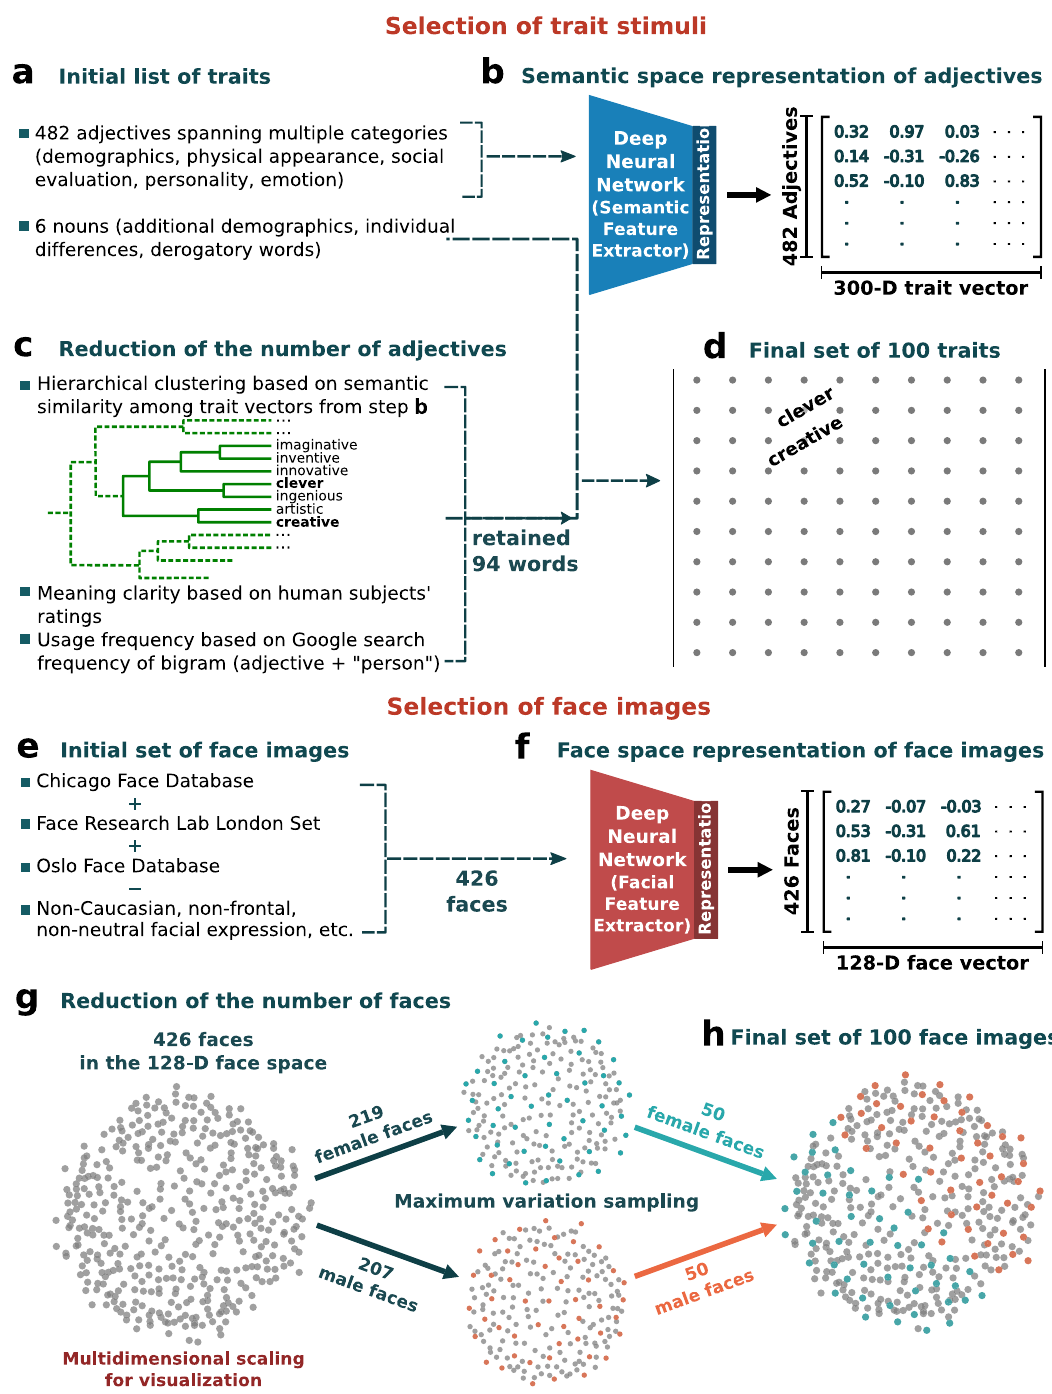
Fig. 1 Sampling traits a – d and face images e – h to generate a comprehensive set. a Sampling of traits began by assembling an extensive list of trait words 1 – 3,8,10,14 – 20,22,37 – 39 spanning all-important categories of trait attributions from faces. b Each adjective was represented with a vector of 300 semantic features that describe word embeddings and text classi fi cation using a state-of-the-art neural network that had been pretrained to assign words to their contexts across 600 billion words 70 . c Three fi lters were applied to remove words with similar meanings, unclear meaning, and infrequent usage (see Methods). d The fi nal set of 100 traits consisted of the sampled adjectives and nouns (see Supplementary Table 1). e Sampling of face images began by assembling a set of frontal, neutral, white faces from three popular face databases 71 – 73 . f, Each face was represented with a vector of 128 facial features that are used to classify individual identities using a neural network 74 pretrained to identify individuals across millions of faces of all different aspects and races. g Maximum variation sampling 86 was applied to select faces with maximum variability in facial structure in this 128-D space. h Multidimensional scaling visualization of the sampled 100 face images (green and orange dots).